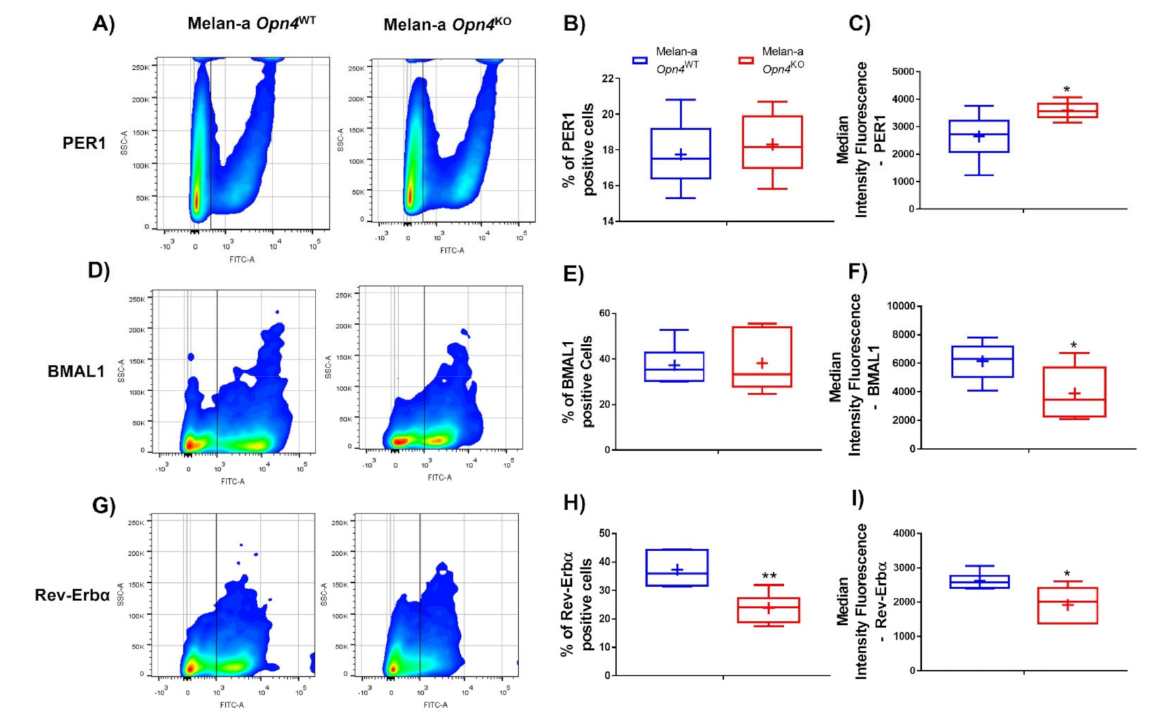
Figure 5. PER1, BMAL1, and REV-ERB α protein evaluation using specific antibodies in flow cytometry in Opn4 WT and Opn4 KO melanocytes. ( A , D , G ) Representative gates of PER1-, BMAL1-, and REV-ERB α -stained cells; ( B , E , H ) percentage of positive cells for a given protein; ( C , F , I ) median intensity fluorescence (MIF). ( n = 4–6). * p < 0.05. ** p <